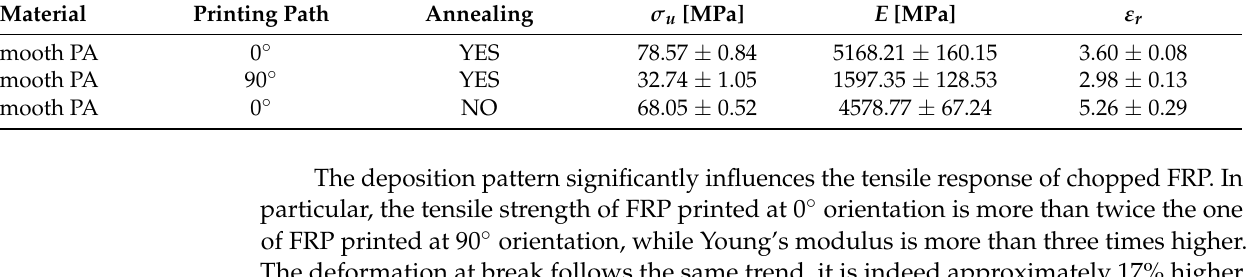
Table 3. Tensile test results—Chopped